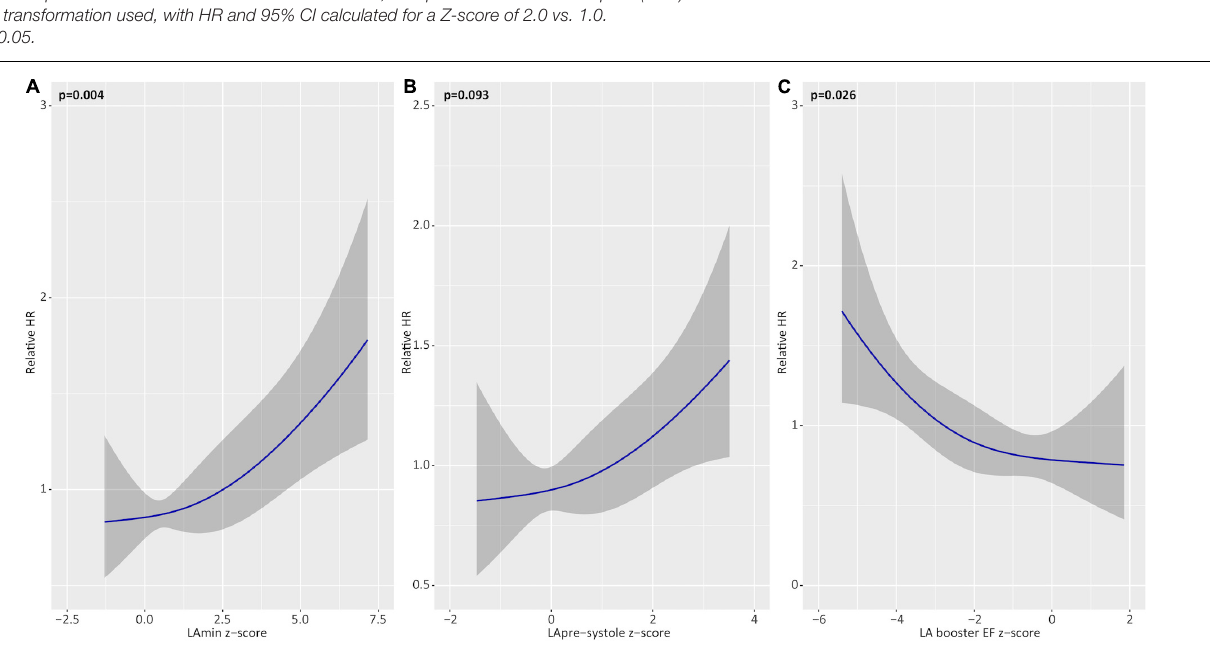
FIGURE 2 | Univariable associations of left atrial (LA) parameters with the primary outcome. Unadjusted hazards of atrial fibrillation recurrence for Z-score based deviations (relative to healthy reference values) for minimum LA volume (LAmin; A ), pre-systole LA volume (LApre-systole; B ), and LA booster ejection fraction (EF; C ). Relative hazard ratios plotted across the range of restricted cubic spline-transformed